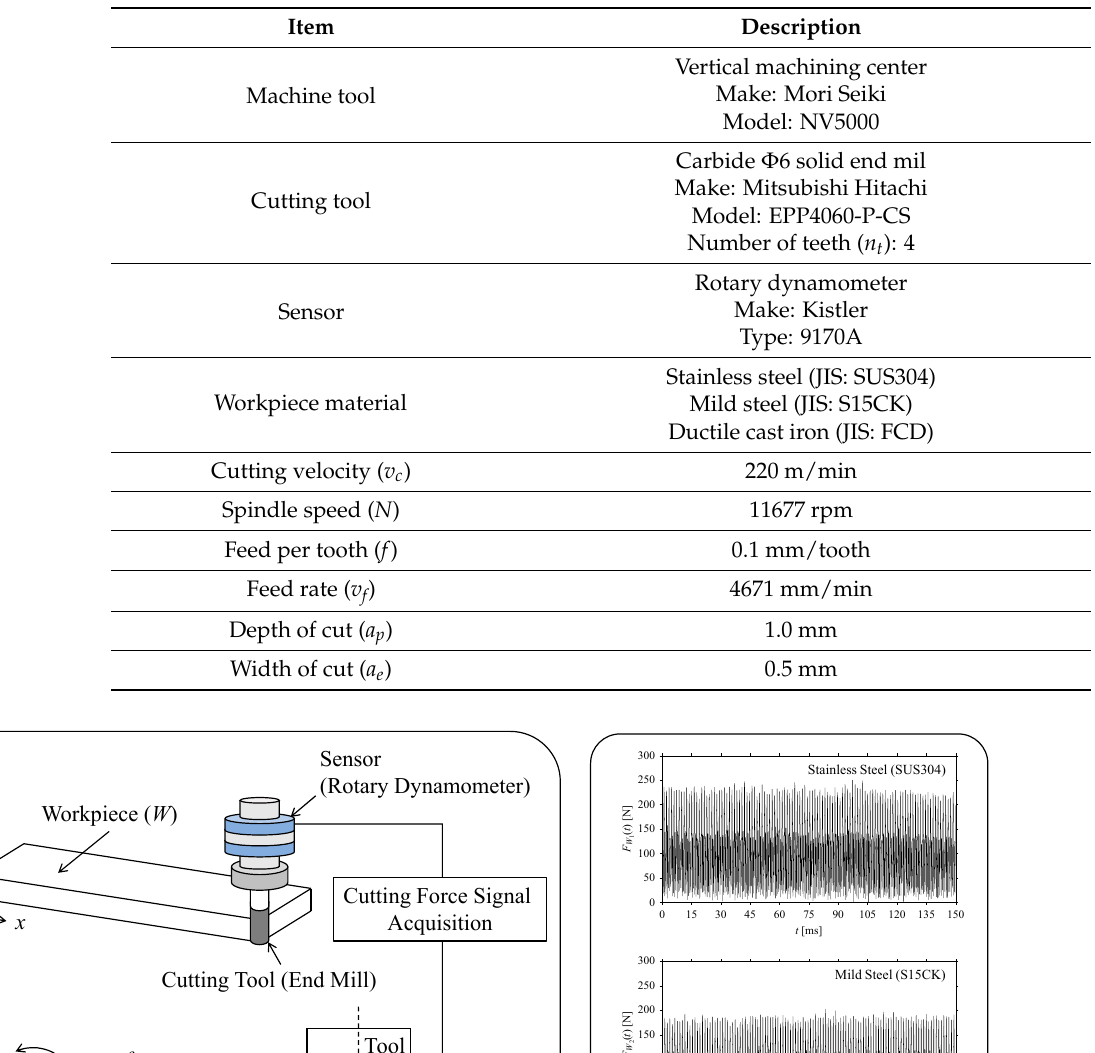
Table 1. Conditions for machining experiment.